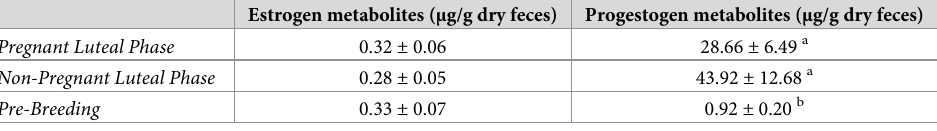
Table 1. Mean ( ± SEM) cheetah estrogen and progestogen fecal metabolite